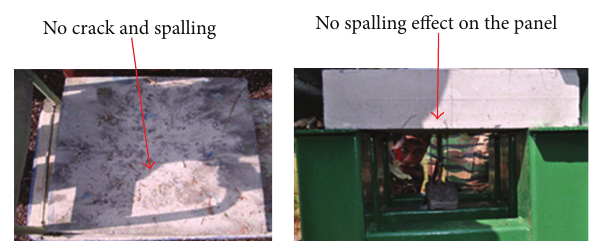
No crack and spalling